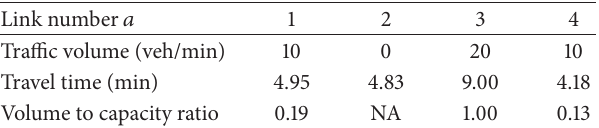
Table 2: Solution of total travel time minimization with signal control only.